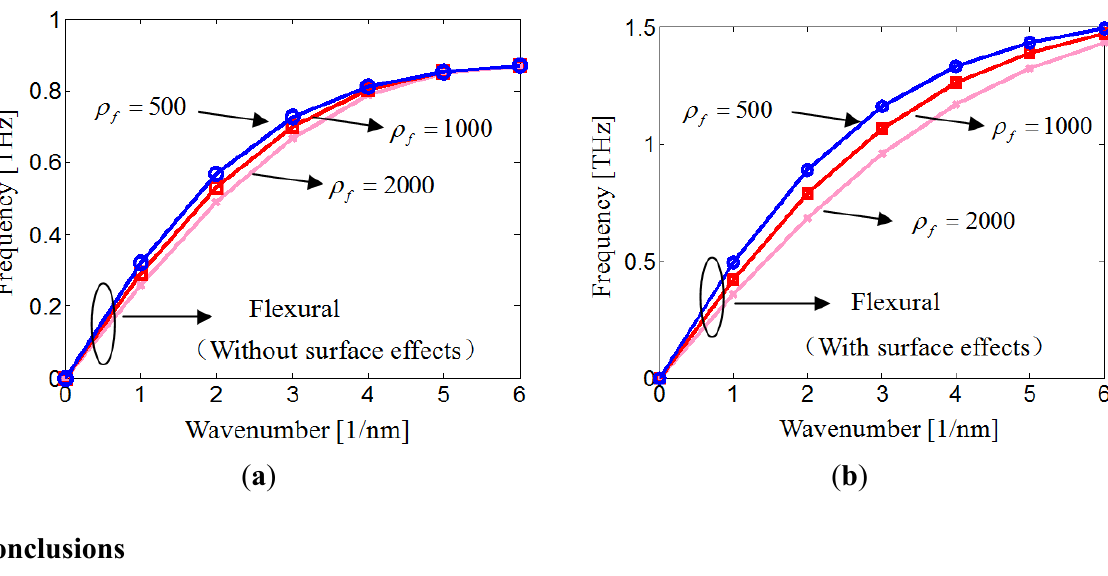
Figure 4. Flexural wave dispersion of nanotube conveying fluid with different fluid